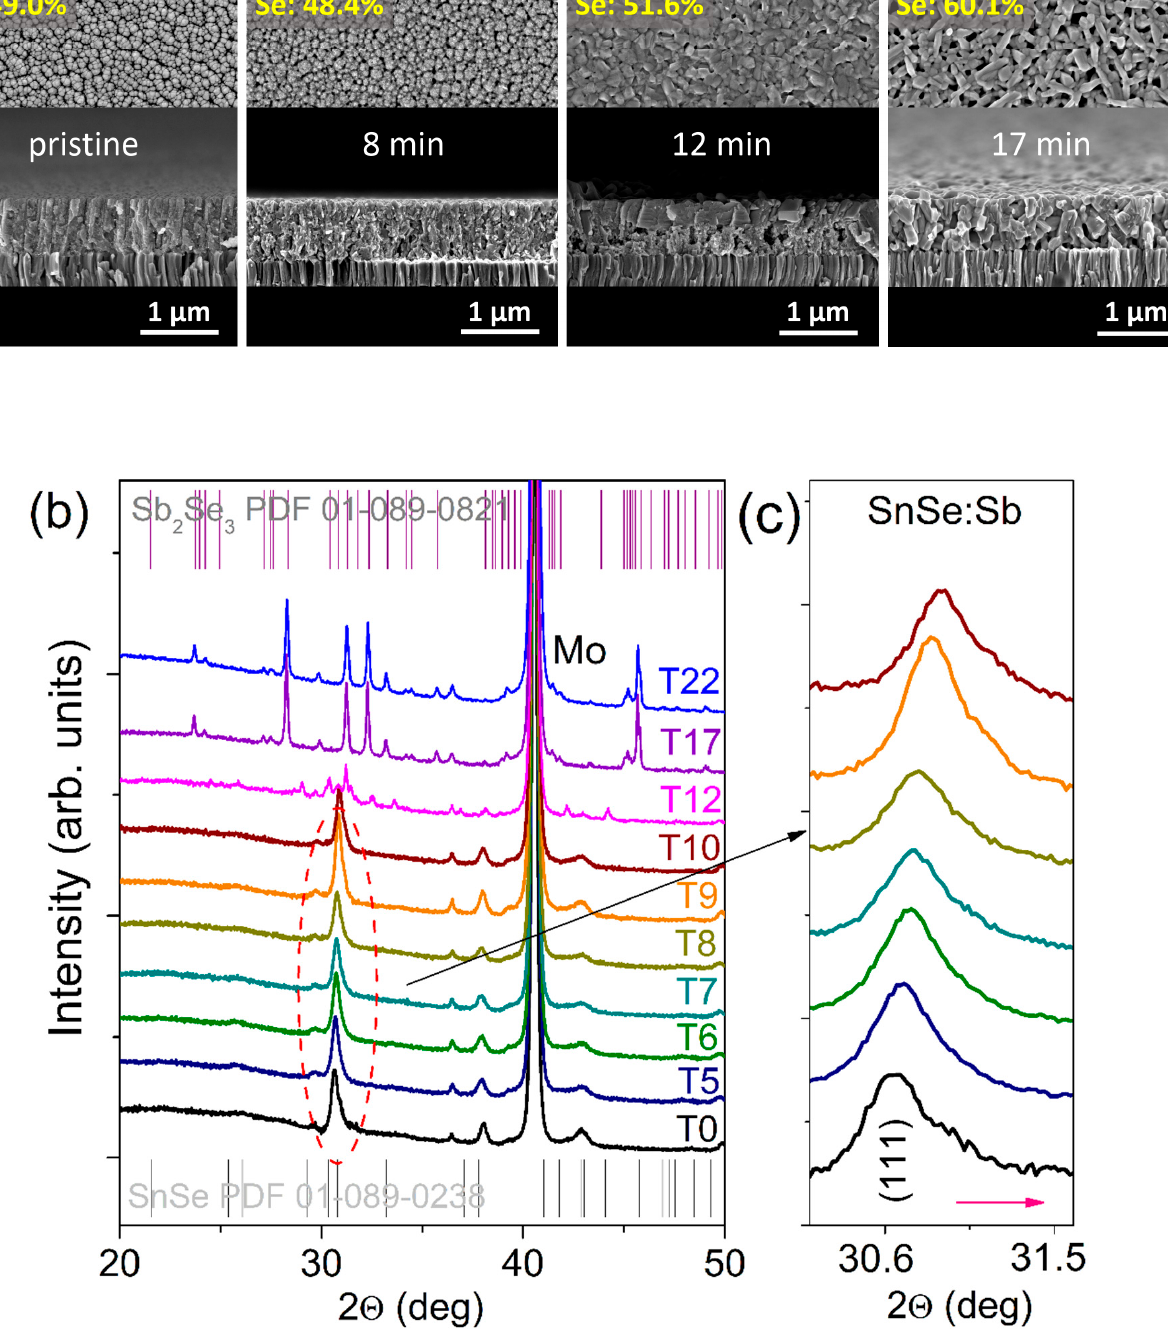
Figure 3. ( a ) SEM images and EDX data, ( b ) XRD patterns of the layers that experienced cation exchange in 44 mM SbCl 3 solutions for a different time. ( c ) Magnified XRD patterns of the (111) peak of the pristine SnSe and antimony-doped SnSe layers.